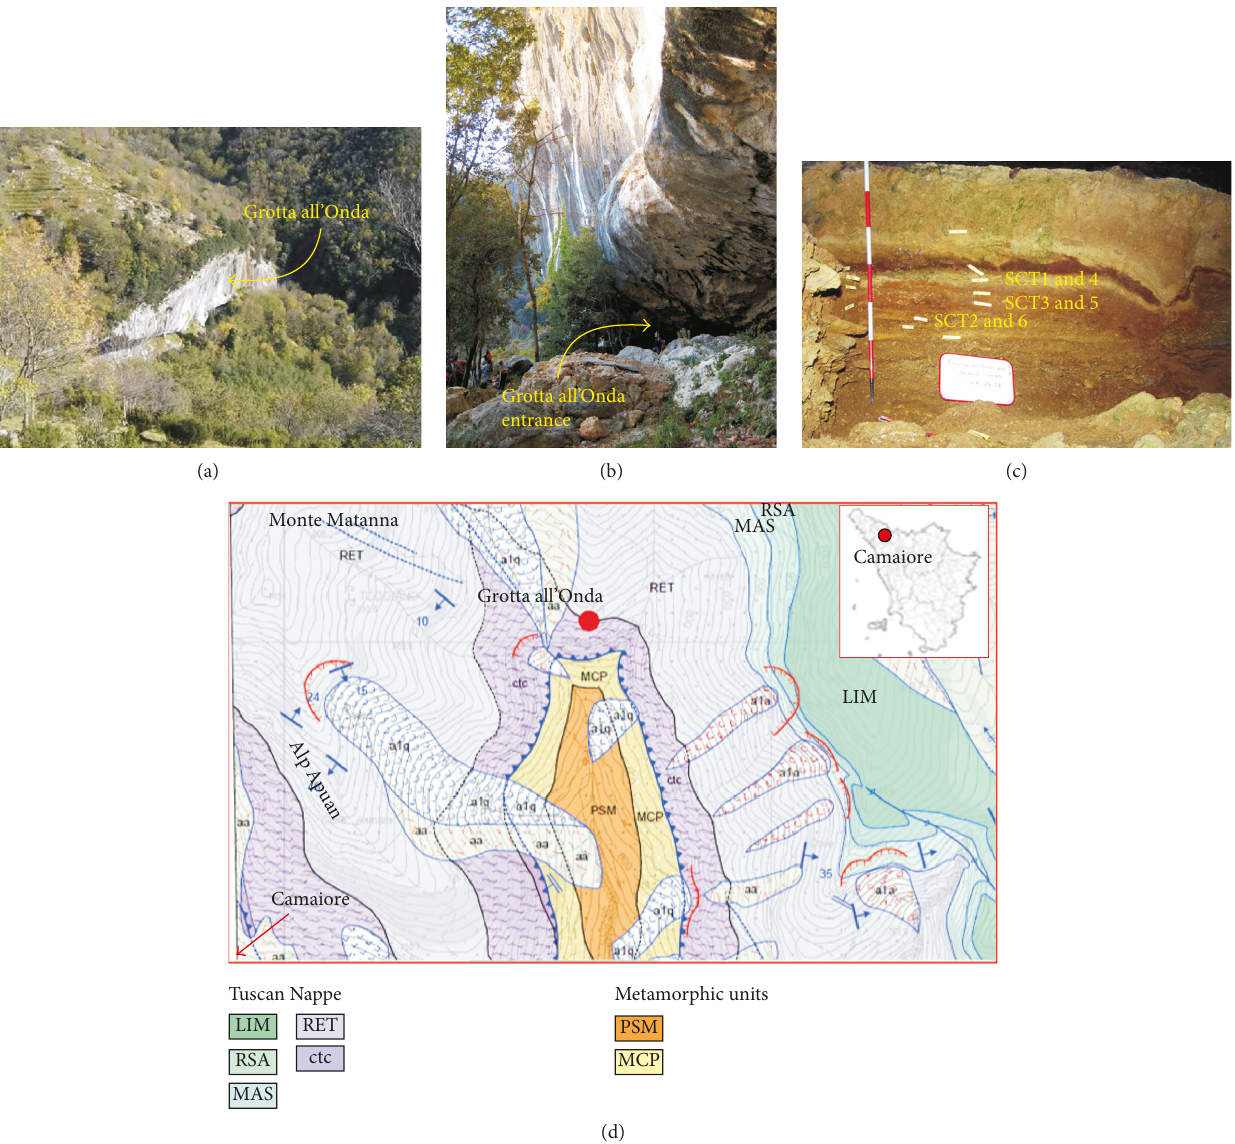
Figure 9: The Ursus spelaeus finding environment. (a) Image of the Grotta all’Onda cave from the above, showing the well-defined cut of the Mt. Matanna flank where the cave is located; (b) image of the entrance of the Grotta all’Onda cave; (c) image of the soil stratigraphy from which the Ursus spelaeus fossil remains have been sampled during the 1999 field campaign; (d) geological sketch map of the area around the Grotta all’Onda cave (http://www502.regione.toscana.it/geoscopio/geologia.html#). Formation of the Tuscan Nappe unit: LIM: “ Calcare Secifero di Limano ” formation; RSA: “ Rosso Ammonitico ” formation; MAS: “Calcare Massiccio” formation; RET: “ Raethavicola Contorta ” formation, Late Triassic dolomitic-limestones; ctc: cataclastic formation made by a polygenic breccias of mainly metamorphic limestone clasts. Tuscan metamorphic units: PSM: “Pseudomacigno” formation; MCP: “Cipollini”